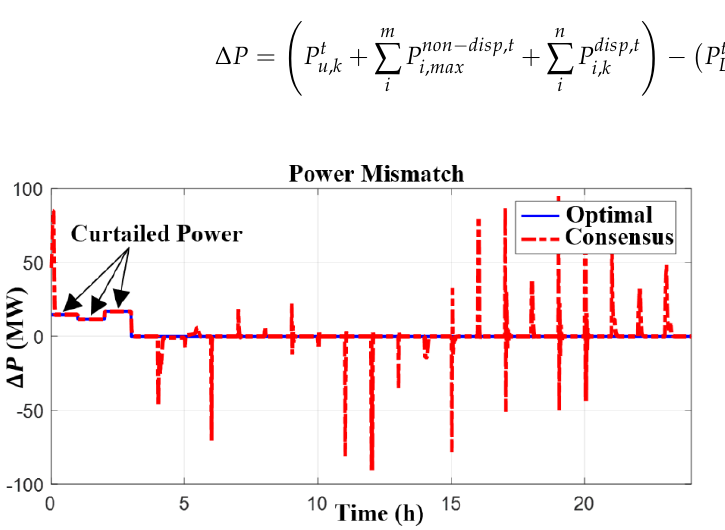
Figure 11. The incremental cost of generators and utility rates.